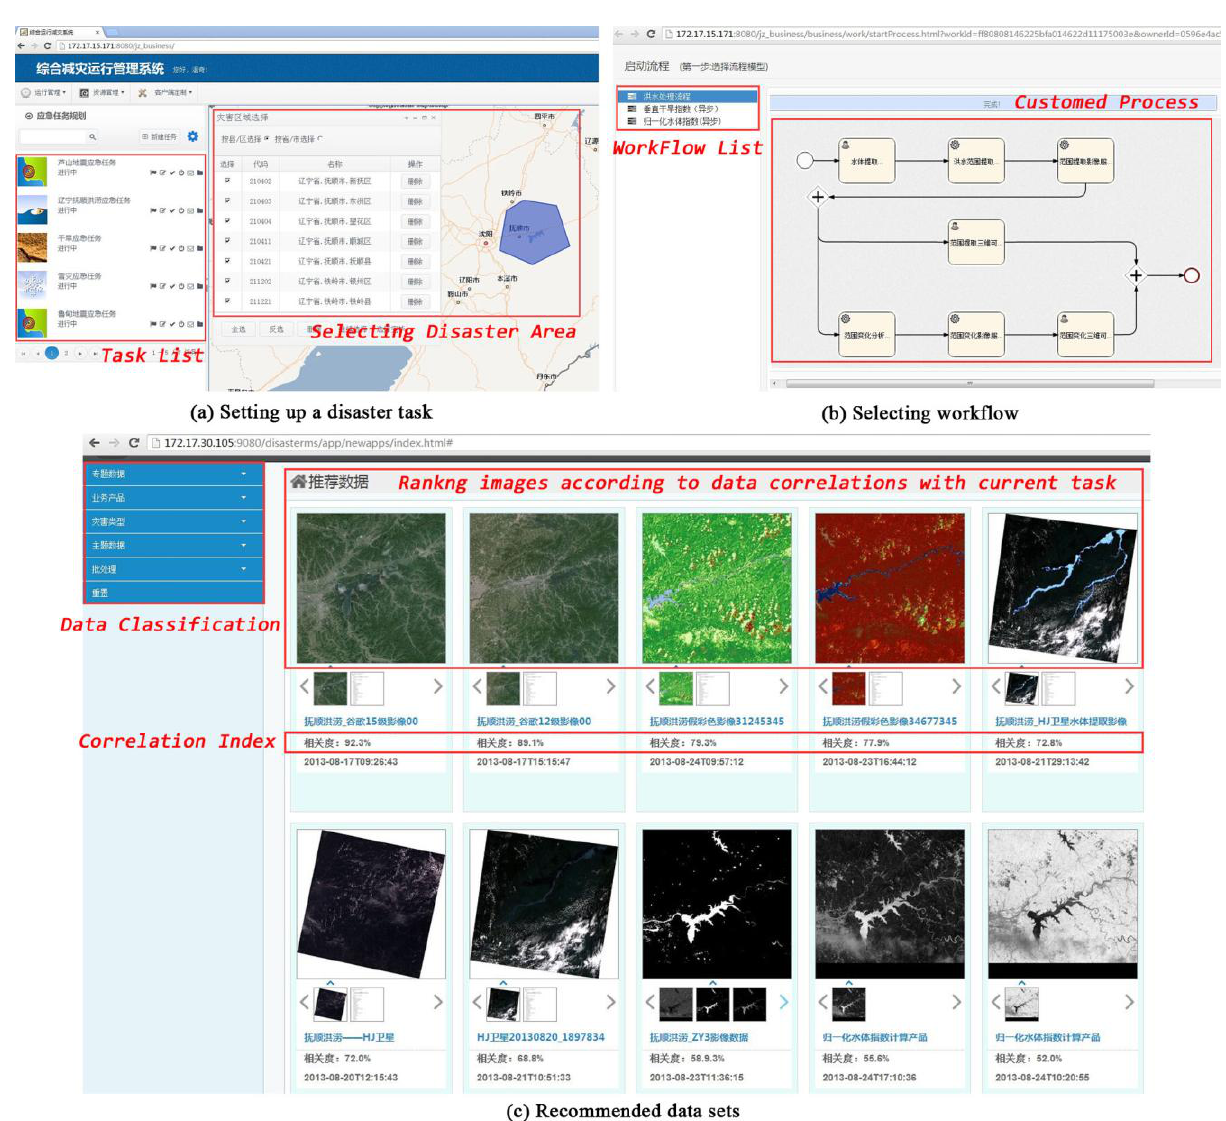
Figure 4. The graphic interface of the prototype